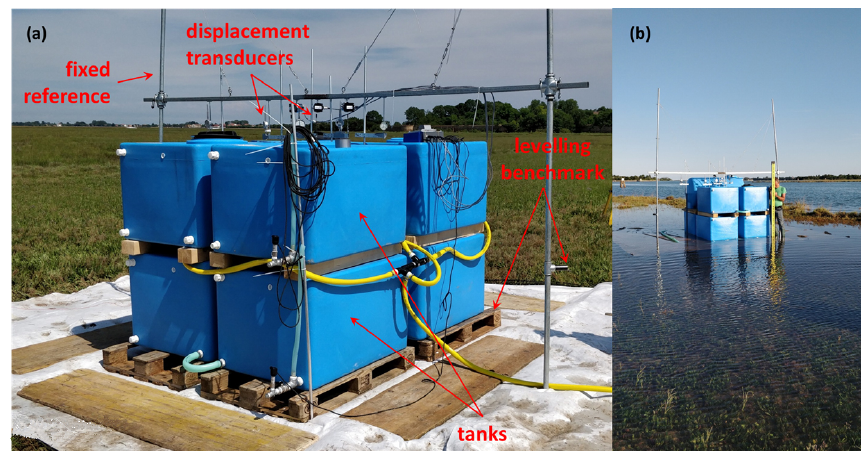
Figure 4. (a) Picture of the loading and monitoring equipment and (b) the experimental equipment in high-tide conditions with the marsh flooded by approximately 0.2m sea water.